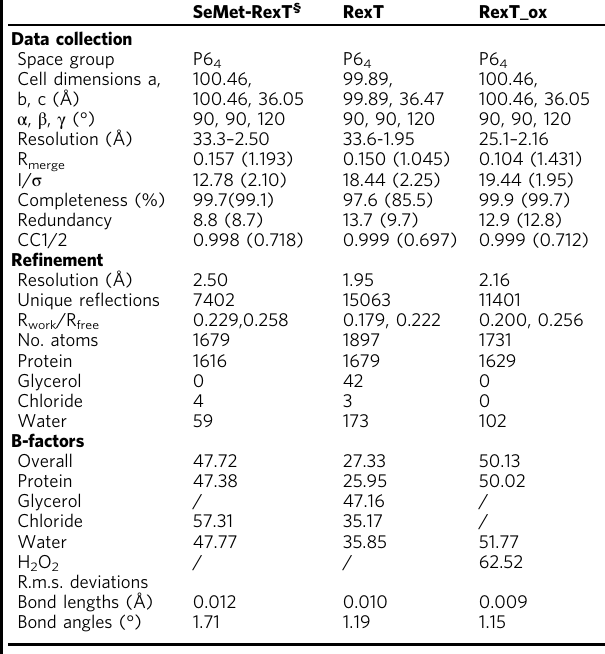
Table 1 Data collection and re fi nement